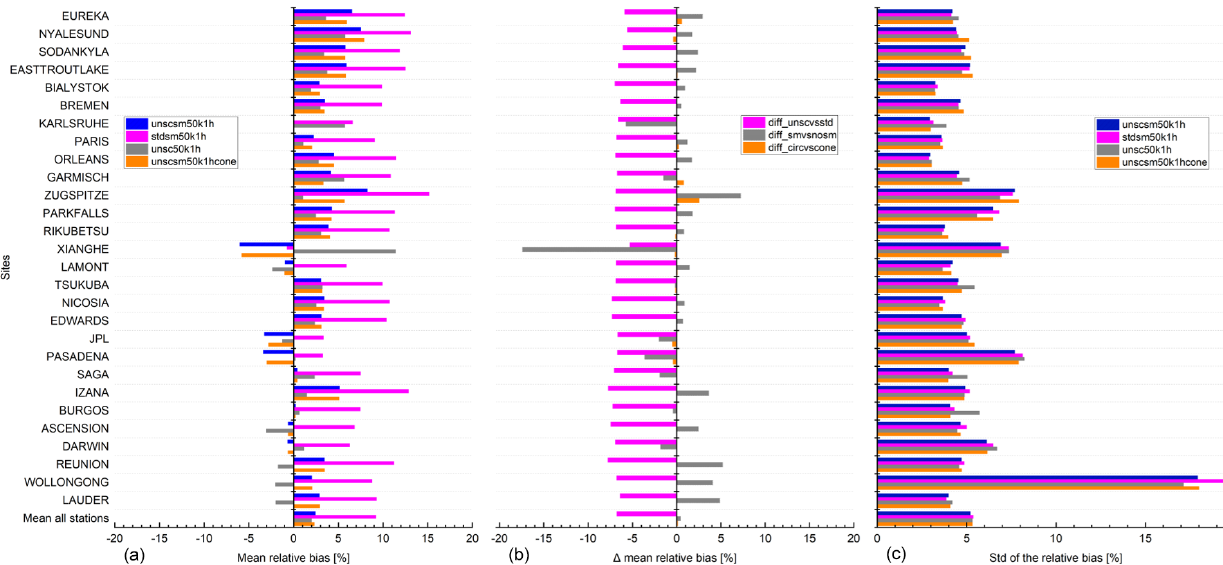
Figure 18. S5P XCO validation results against TCCON XCO data at 28 stations within the period between November 2017 and September 2020. (a) Bar chart of mean relative bias ((SAT – GB)/GB) in percent; (c) standard deviation of the relative bias in percent; (b) difference of the mean relative bias for validation cases (stdsm5ok1h, unsc50k1h, unscsm50k1hcone) in percent against the reference case (unscsm50k1h) in percent. Spatial co-location with radius of 50km or cone with 1 ◦ opening angle along the FTIR line of sight and time co-location of ± 1h around the satellite overpass were used. The stations are sorted with decreasing